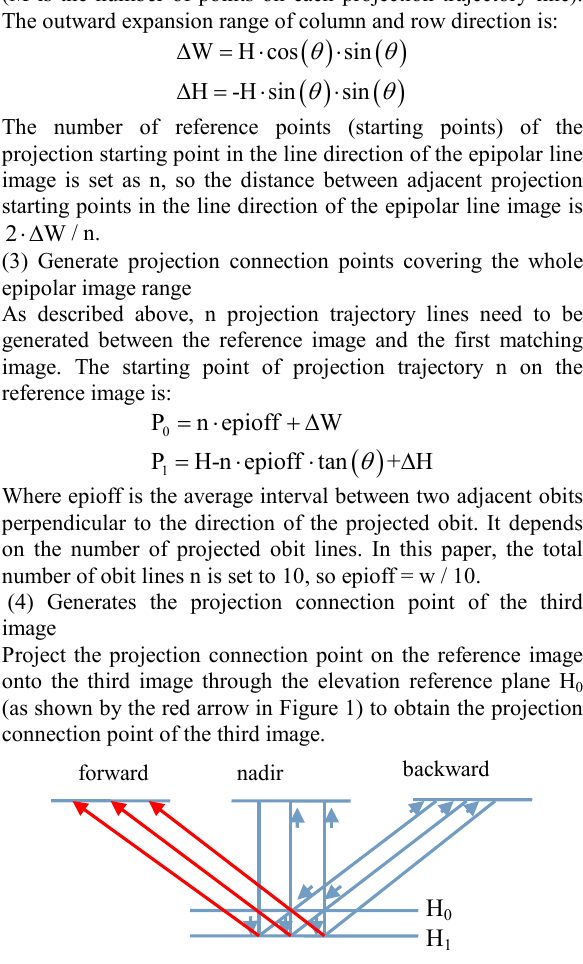
Figure 1 Process diagram of obtaining projection connection points by double projection plane